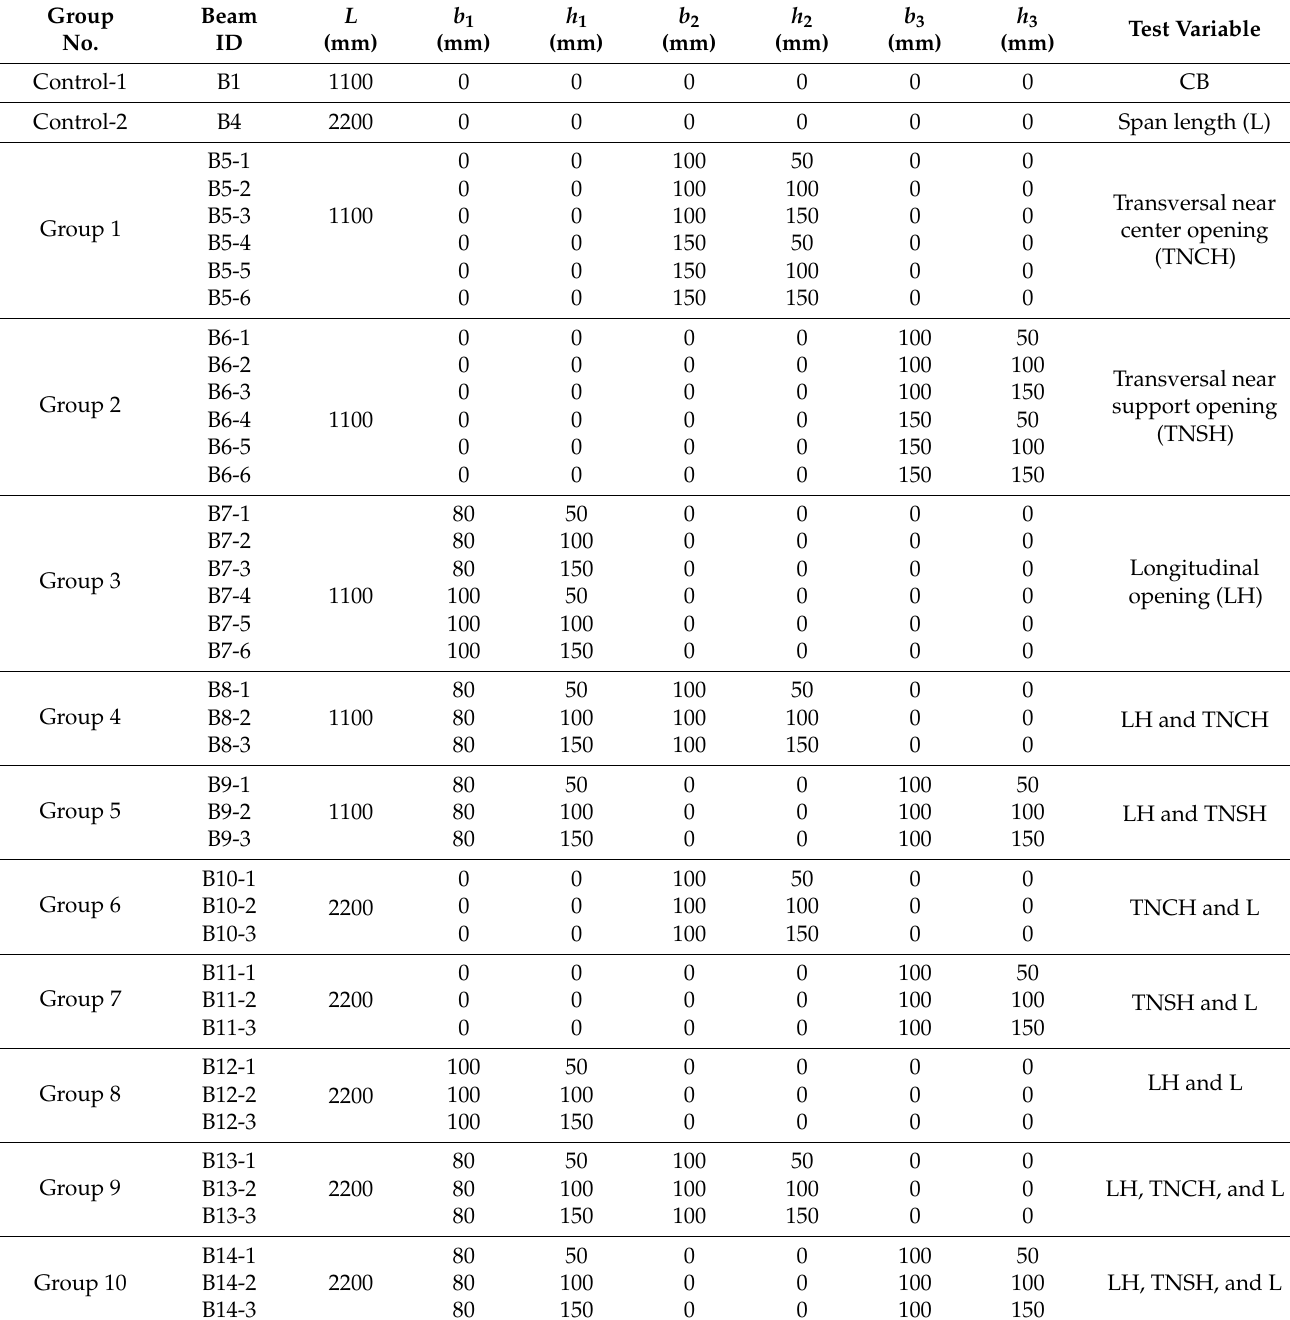
Table 5. Details of the simulated beams with different